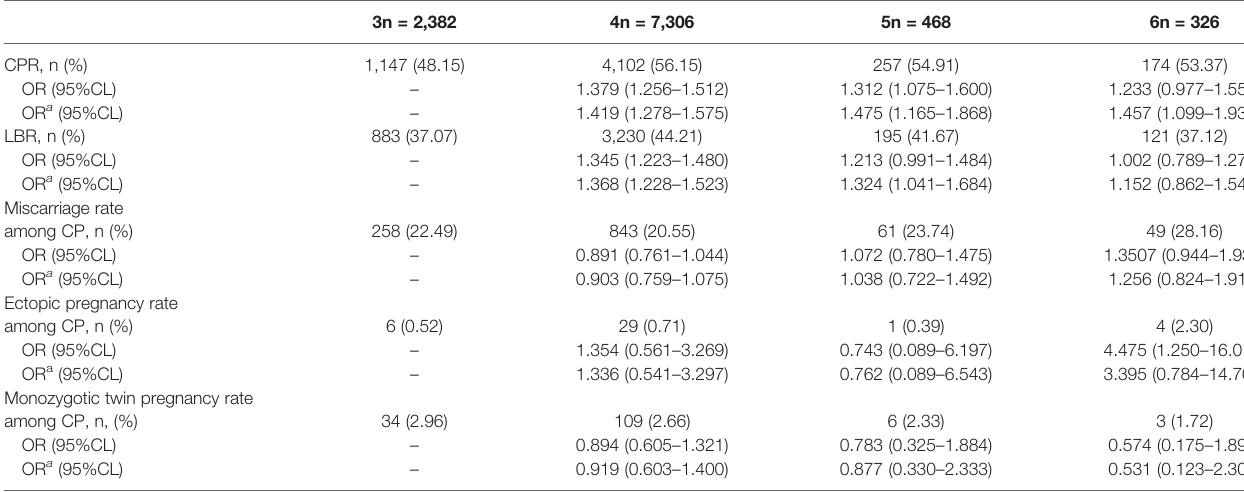
TABLE 2 | Pregnancy outcomes according to the blastocyst expansion